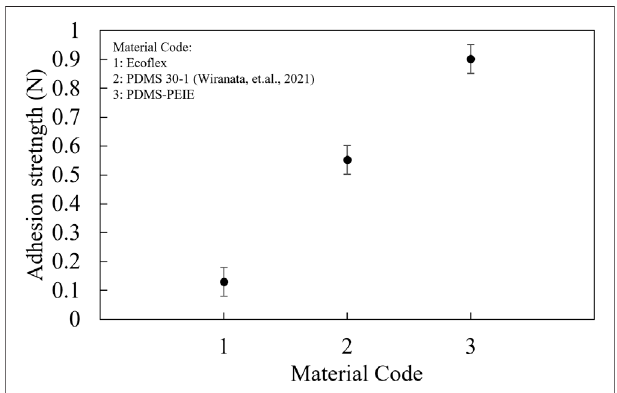
FIGURE 8 | Tackiness of the elastomer